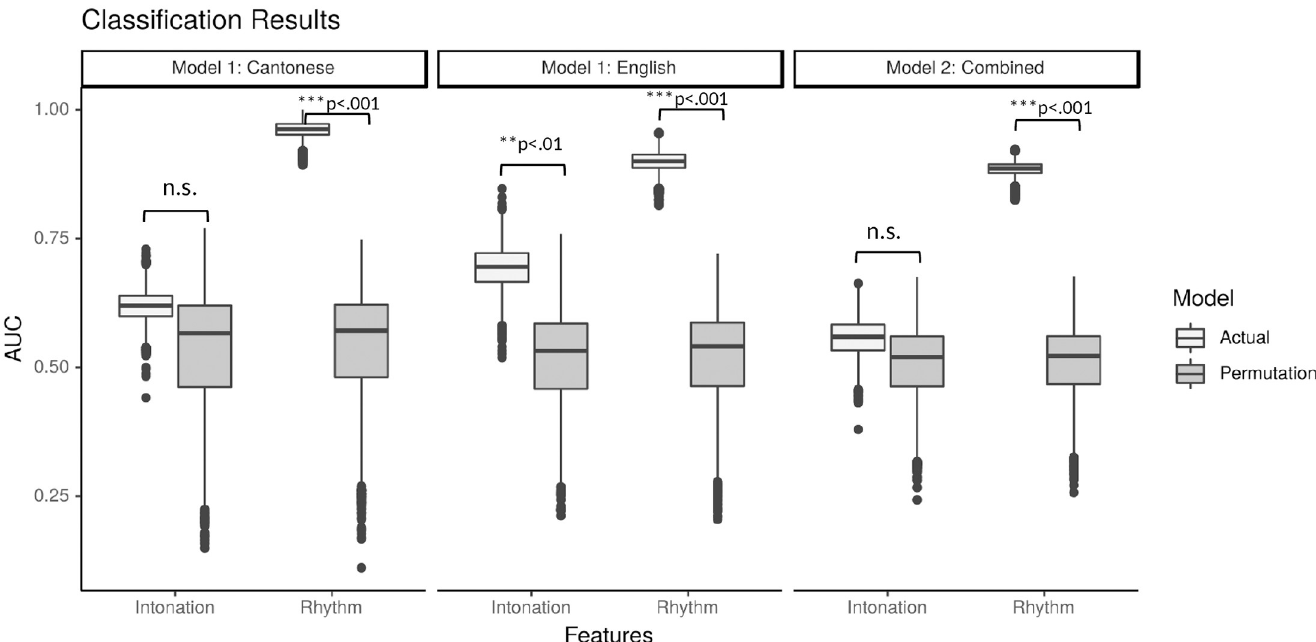
Fig 1. Machine learning classification results. Machine learning classification results displayed in boxplots of Area-Under-the-Curve values across 5001 iterations and permutations.